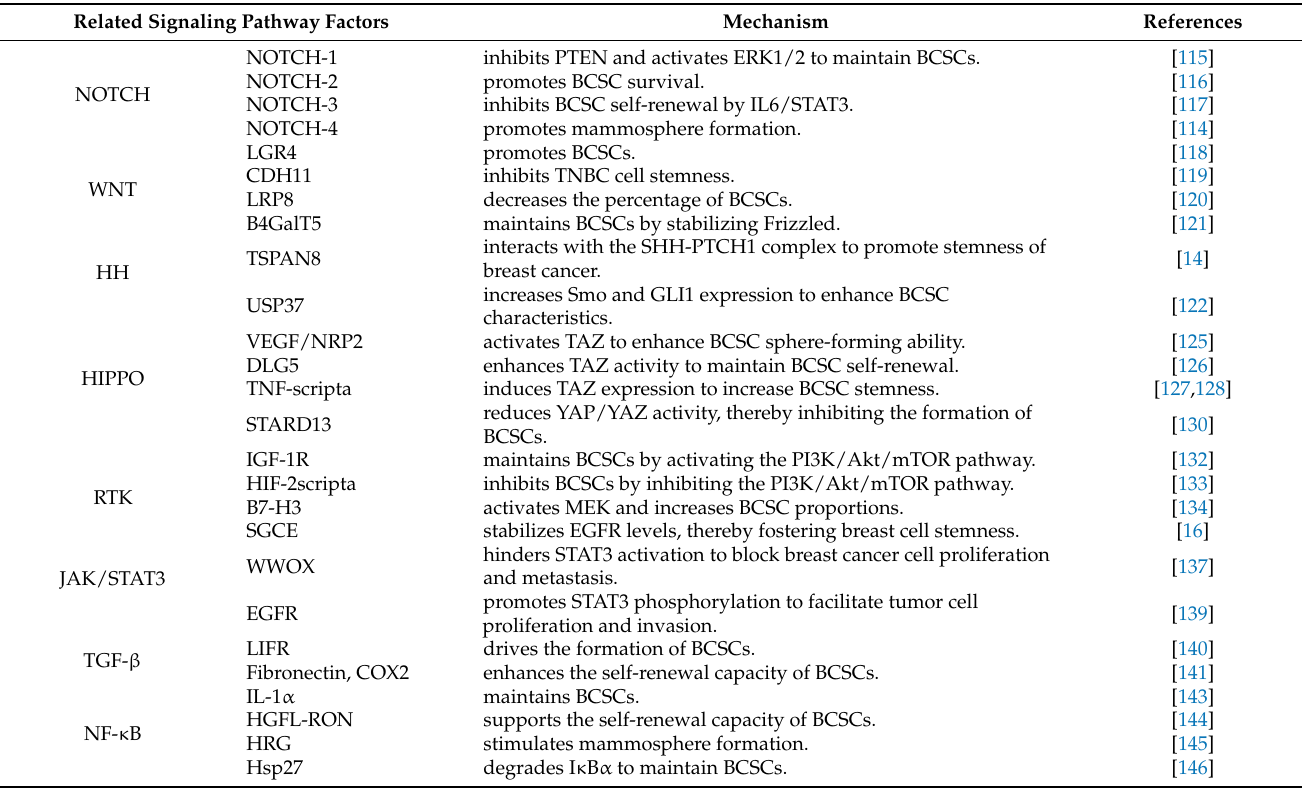
Table 4. Signal transduction pathways regulating